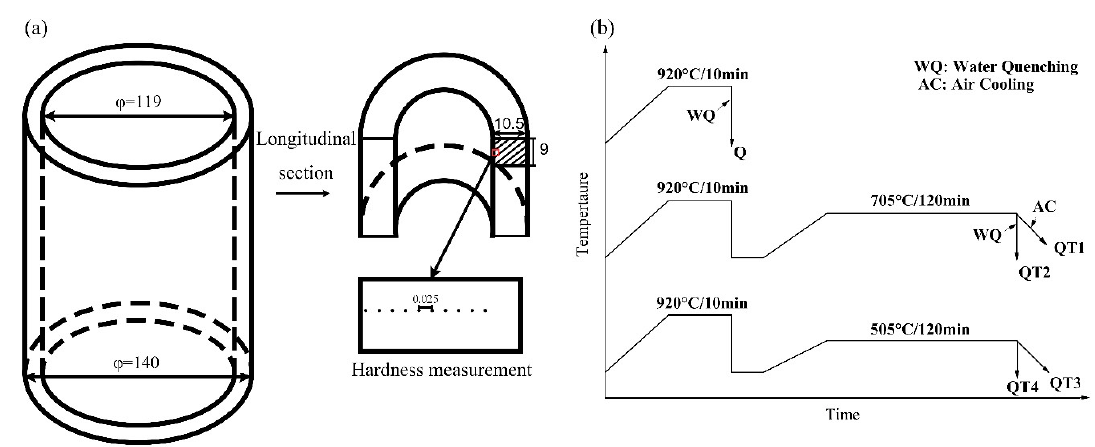
Figure 1. Schematic diagram of the as-rolled tube ( a ) and the specimen hot treatment processes ( b ) (unit: mm).